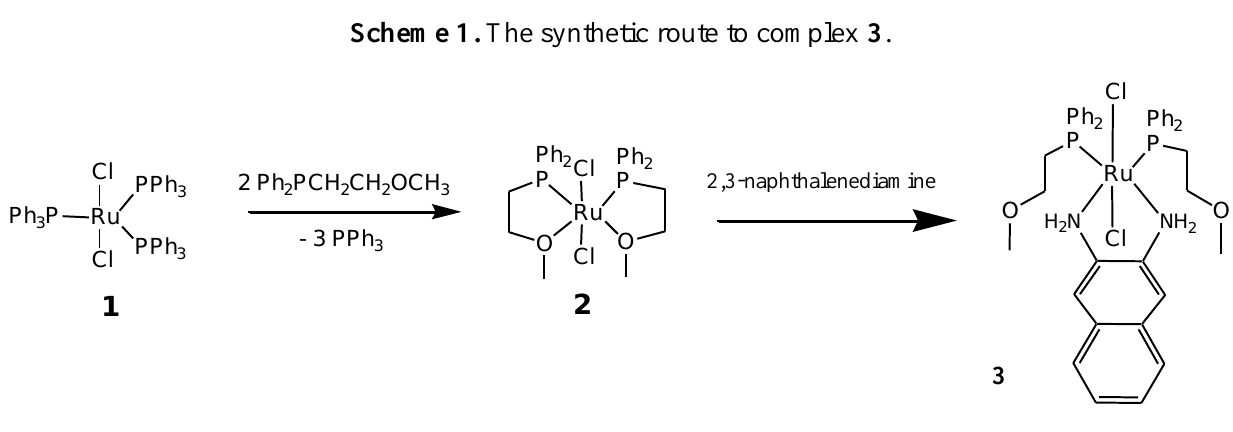
Figure 1. Time-dependent 31 P{ 1 H}-NMR spectroscopy of complex 2 at 